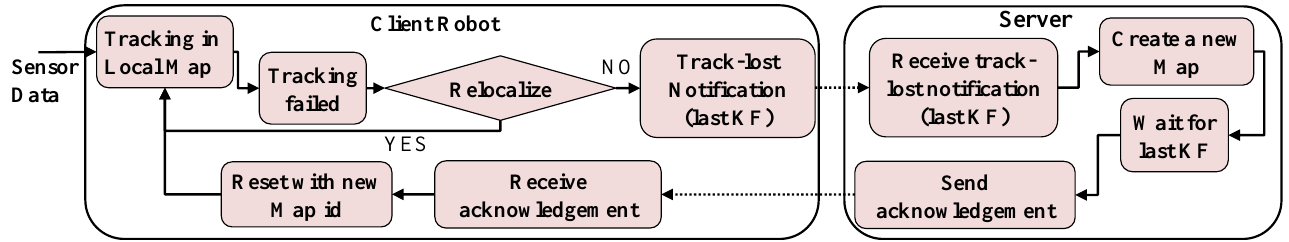
Figure 3. Block diagram of information flow after camera tracking